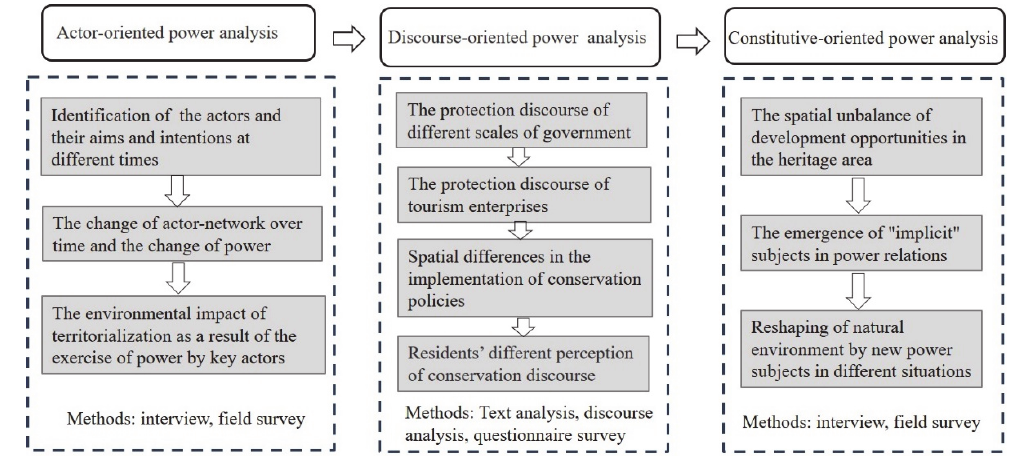
Figure 1. The research framework.